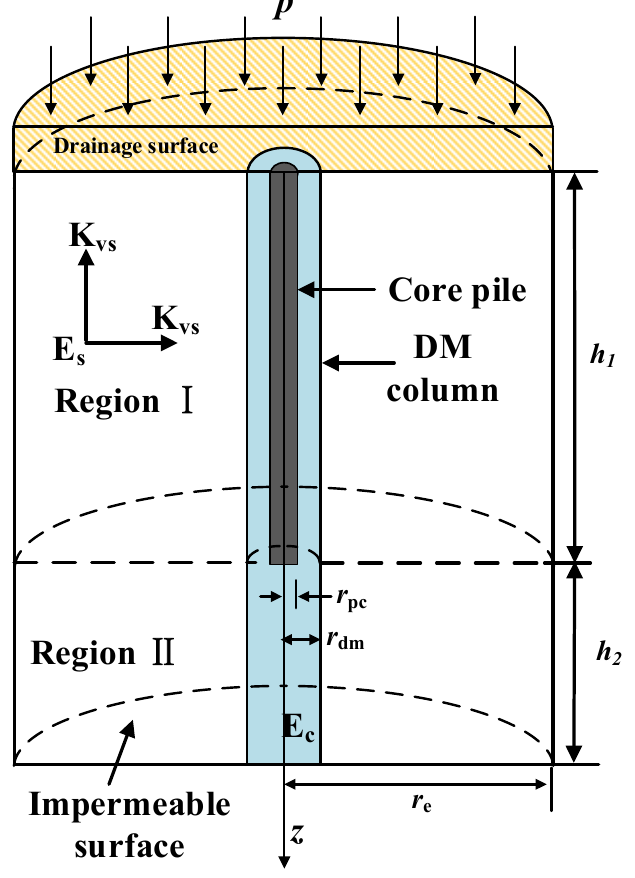
Figure 5. Analytical consolidation model of the SDM column-supported embankment [62].